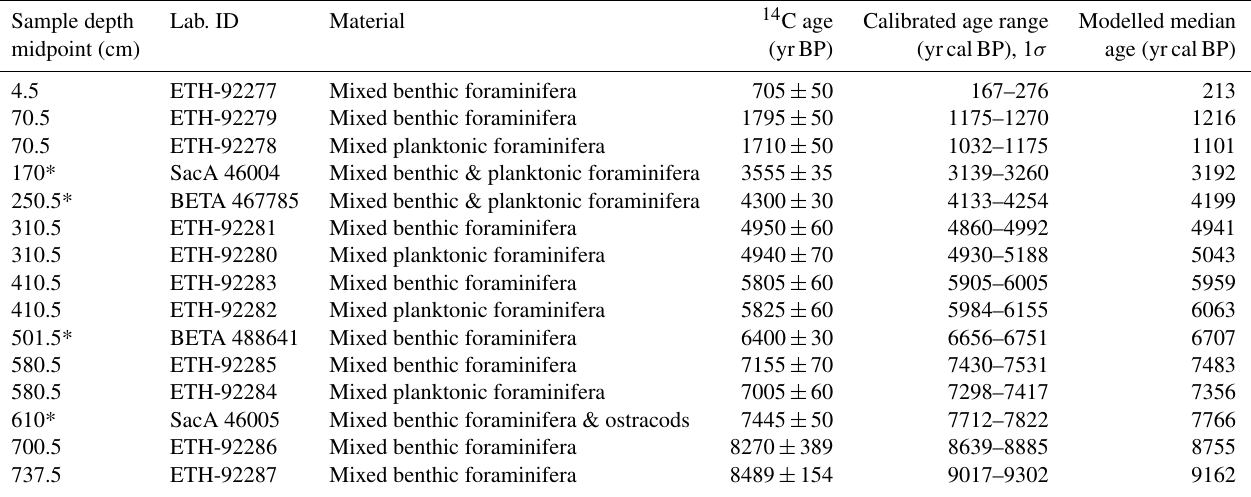
Table 1. List of radiocarbon dates and modelled ages in core AMD14-204C. The dates with a * sign have previously been published in Caron et al. (2018). All dates were calibrated using the Marine13 calibration curve (Reimer et al., 2013) and (cid:49)R = 140 ± 30 years. Sample